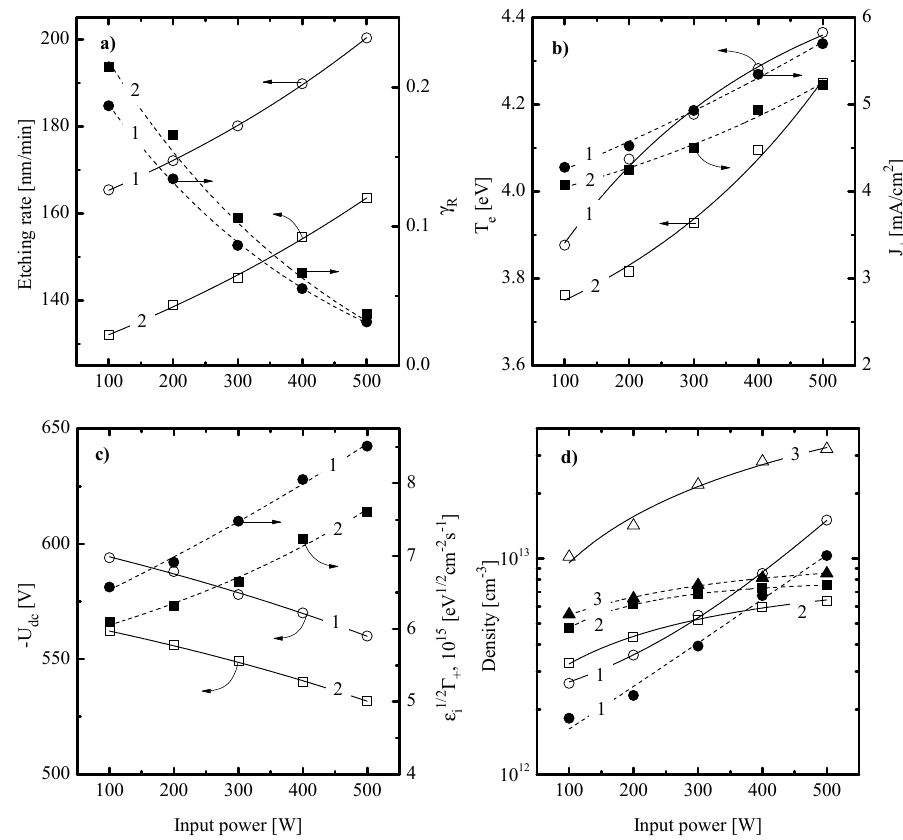
Figure 2. Effect of input power on SiO x N y etching kinetics ( a ) and plasma characteristics ( b – d ) at p = 10 mTorr for 45% CF 4 + 45% C 4 F 8 (CF 2 Br 2 ) + 10% O 2 gas mixtures: %: ( a ) etching rate and effective reaction probability; ( b ) electron temperature and ion current density; ( c ) negative dc bias and the √ ε Γ parameter + characterizing ion energy flux; and ( d ) atoms and radical densities. Numerical labels i on curves are as in Figure